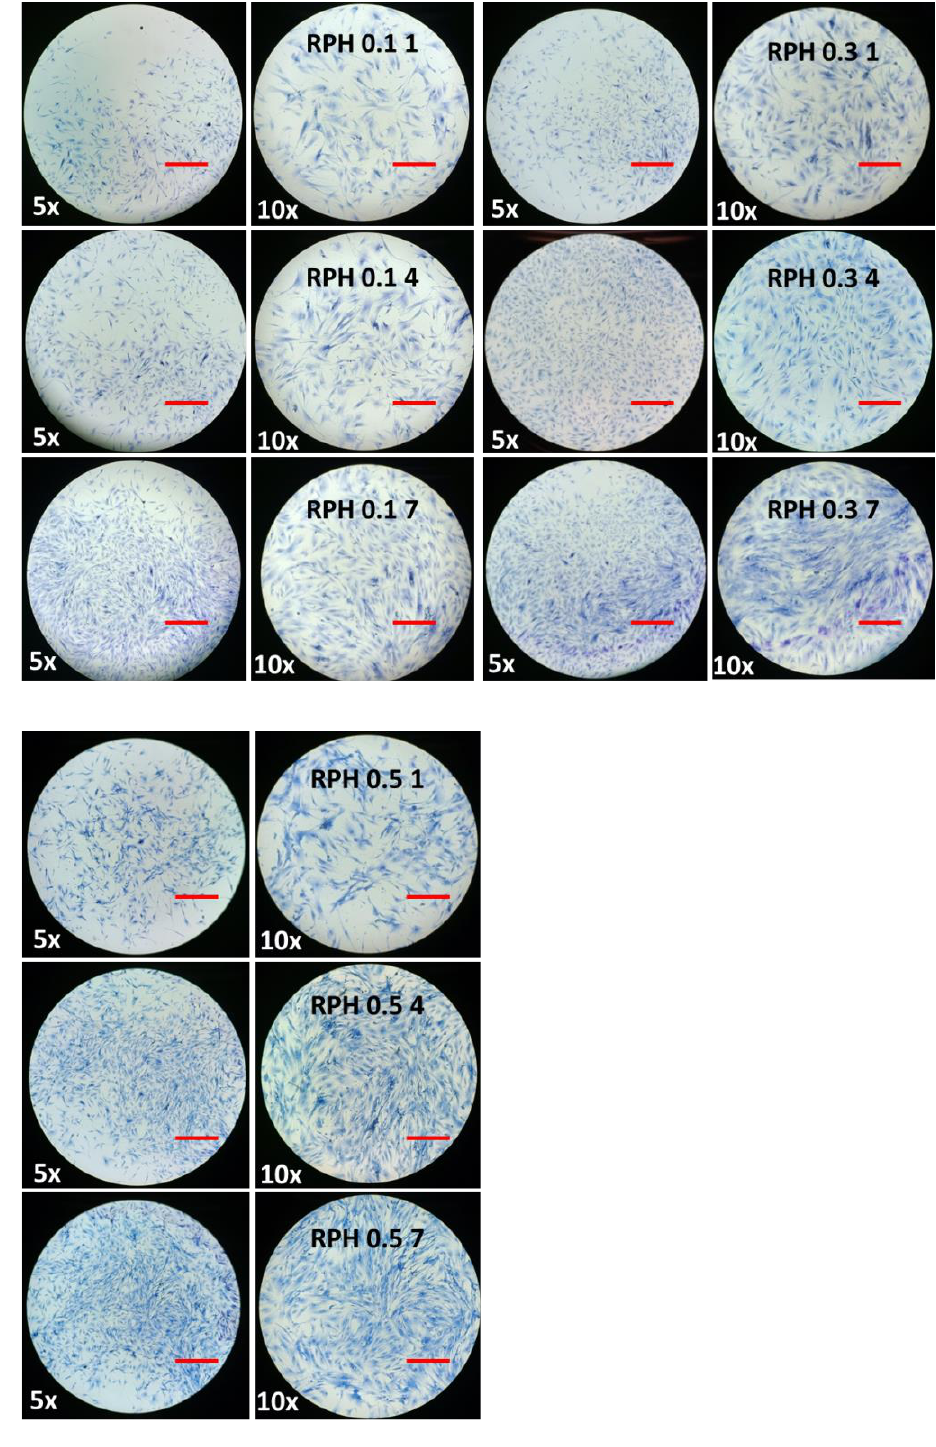
Figure 9. The hematoxylin- and eosin-stained images of bone marrow mesenchymal stem cells cultured in RPHX hydrogels for 1, 4, and 7 days. Control cells treated without hydrogel, PVA solution 15 wt.%, RPH 0.1-0.1% retinol PVA, RPH 0.3-0.3% retinol PVA, RPH 0.5-0.5% retinol PVA. Scale bars 5× —200 μm, 10×—100 μm.